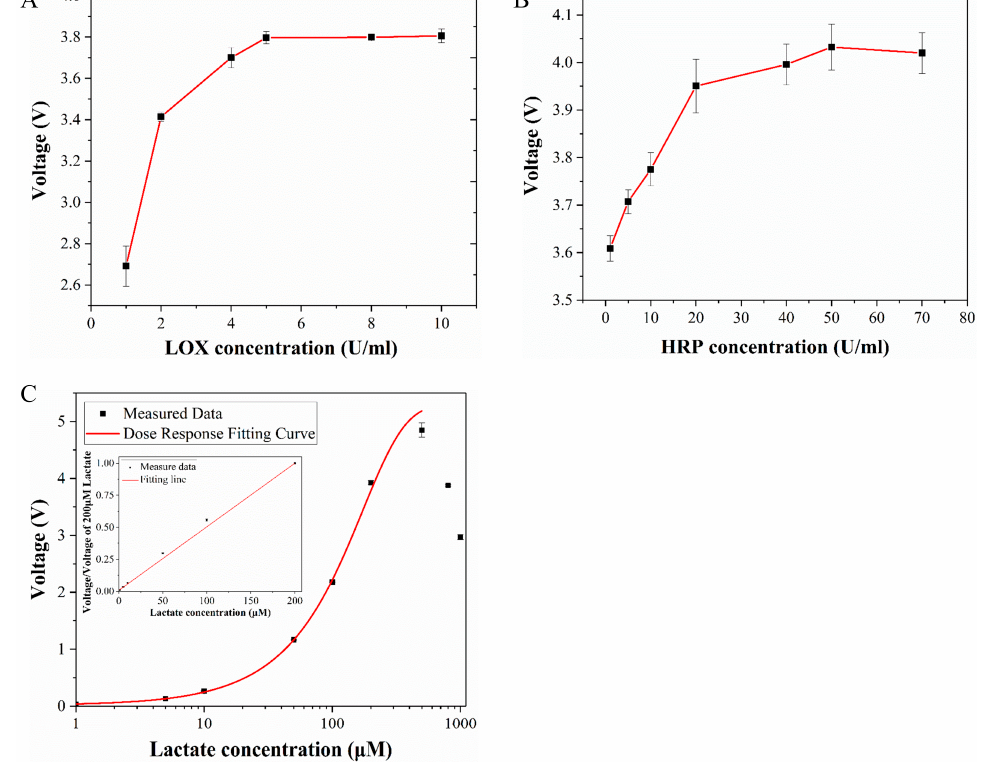
Figure 3. ( A ) E ff ect of lactate oxidase concentration on detection results. ( B ) E ff ect of horseradish Figure 3. ( A ) Effect of lactate oxidase concentration on detection results. ( B ) Effect of horseradish peroxidase concentration on detection results. ( C ) Standard curve of lactate. peroxidase concentration on detection results. ( C ) Standard curve of